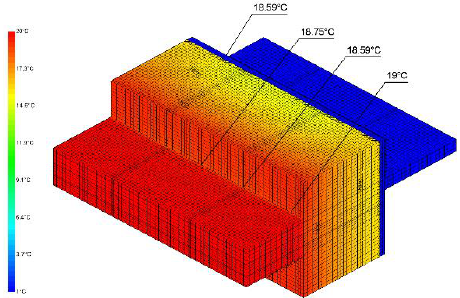
Figure 24. Internal surface temperature distribution field on the wall and deck—top view.